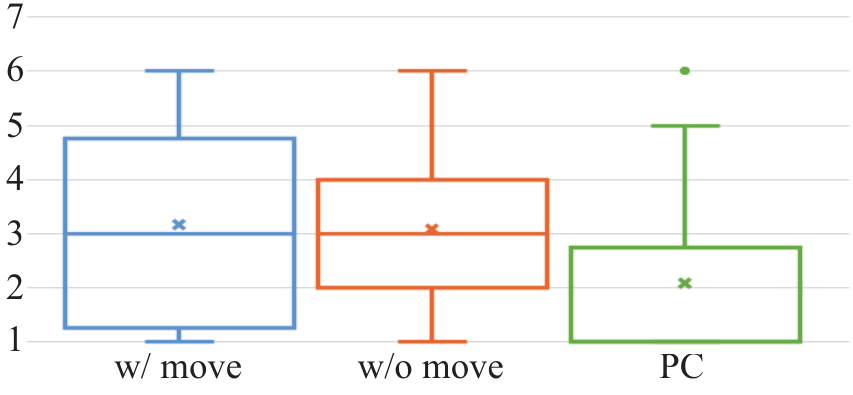
Figure 5. Results (“Did you experience motion sickness?”)